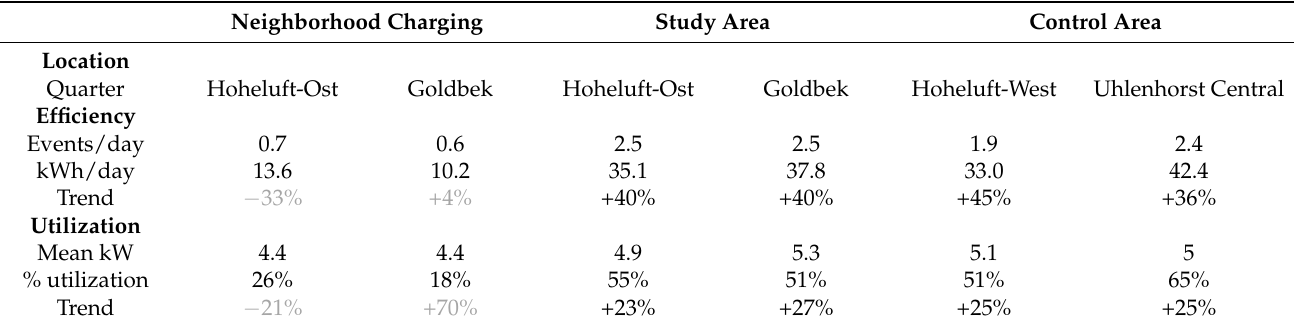
Table 4. Utilization of public charging infrastructure.